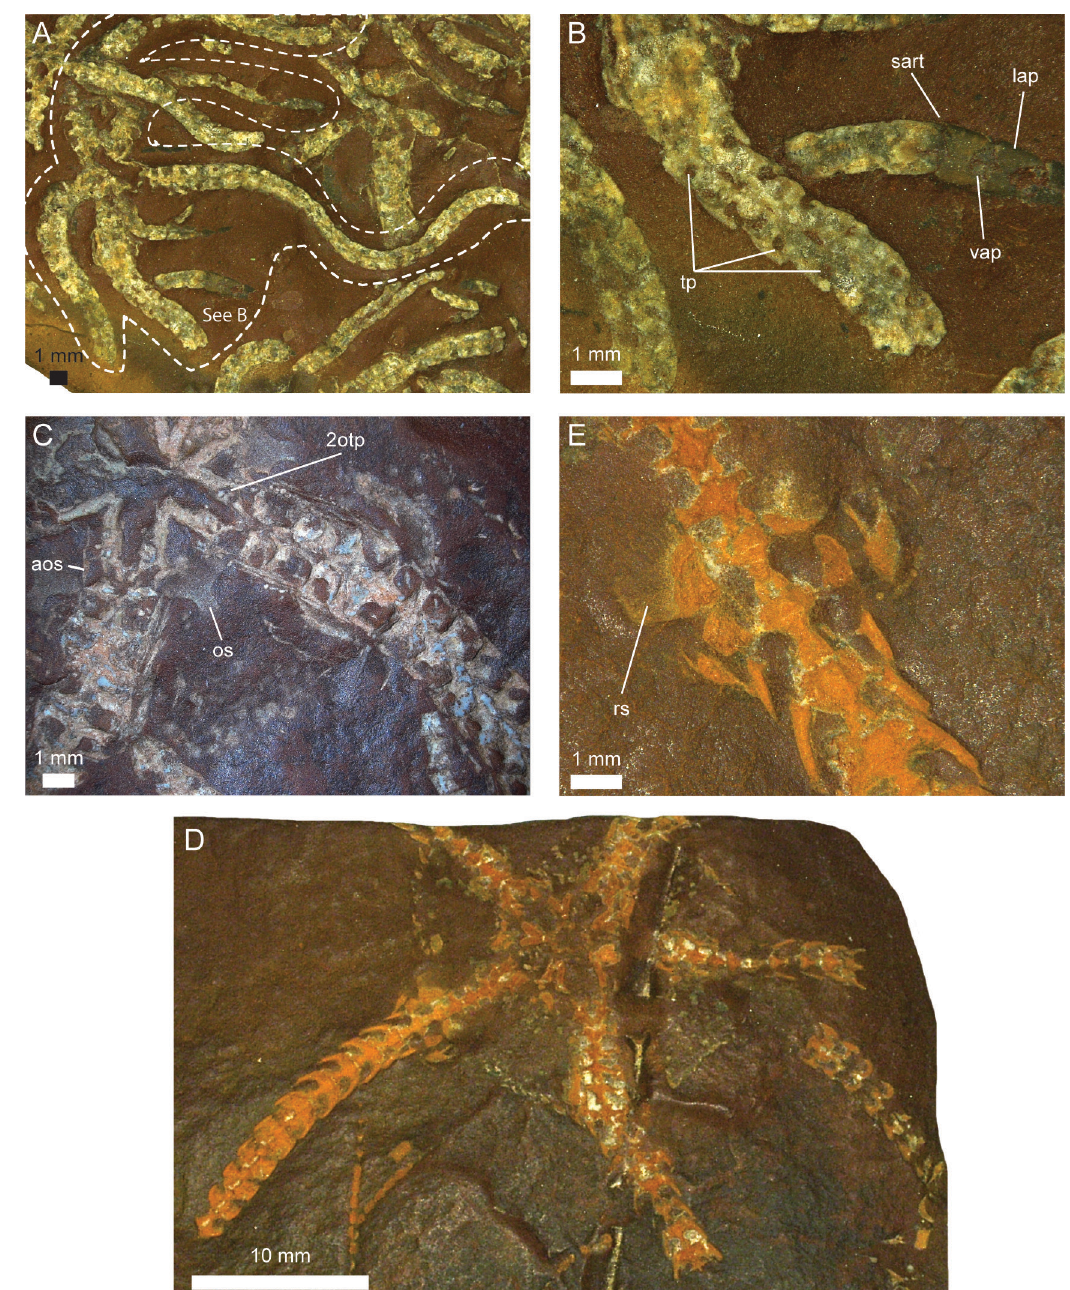
Fig. 7. Ophioculina hoybergia Rousseau & Thuy gen. et sp. nov., paratypes. A–B . Paratype PMO 218.001c. A . Nearly complete specimen (outlined) preserving five arms and the ventral side of the disc, on a concretion slab with an accumulation of specimens. B . Detail view of arm section. C . Paratype PMO 218.048. Articulated ventral disc preserving good details of the oral plates, the second oral tentacle pores and the rows of papillae bordering the genital slit. D–E . Paratype PMO 218.010b. D . Articulated specimen preserving the basal portion of five arms and showing details of the dorsal disc. E . Detail view of arm section. Abbreviations: aos = adoral shield; lap = lateral arm plate; os = oral shield; rs = radial shield; sart = spine articulation; tp = tentacle pore; vap = ventral arm plate; 2otp = second oral tentacle